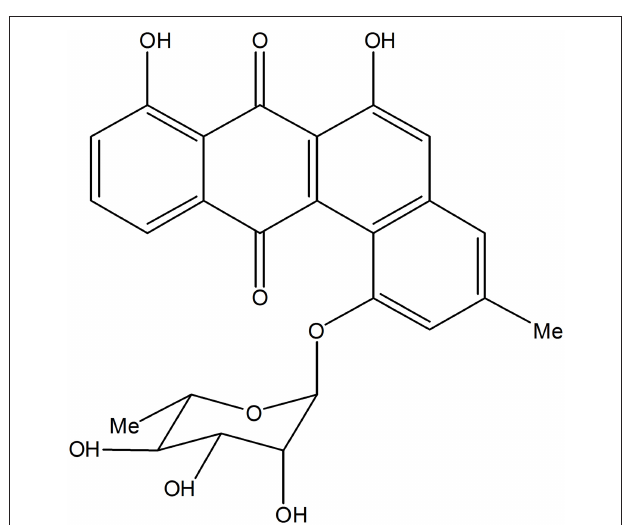
FIGURE 6 | Structure of amycomycin